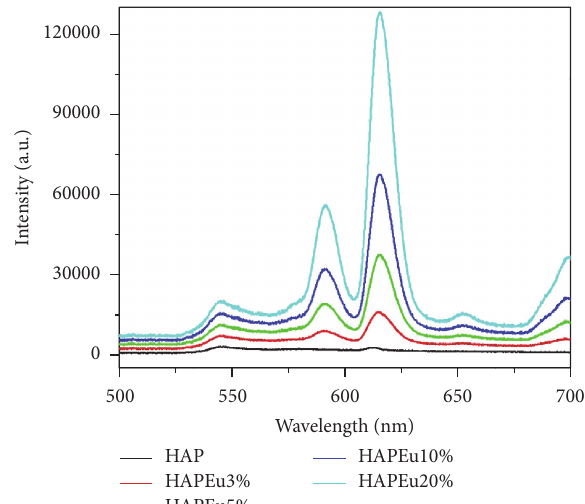
Figure 4: Photoluminescence of HAP and HAPEu nanoparticles measured at room temperature. Excitation source was at